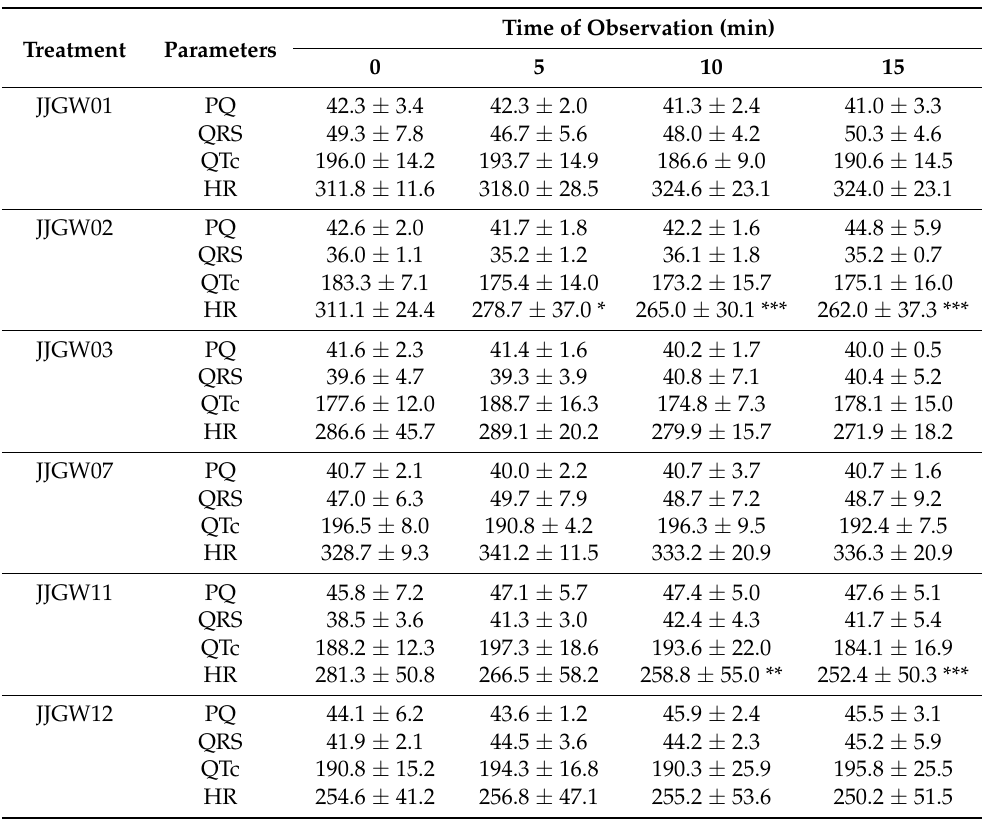
Table 5. The influence of studied compounds on the electrocardiogram (ECG) parameters and heart rate in rats. Treatment